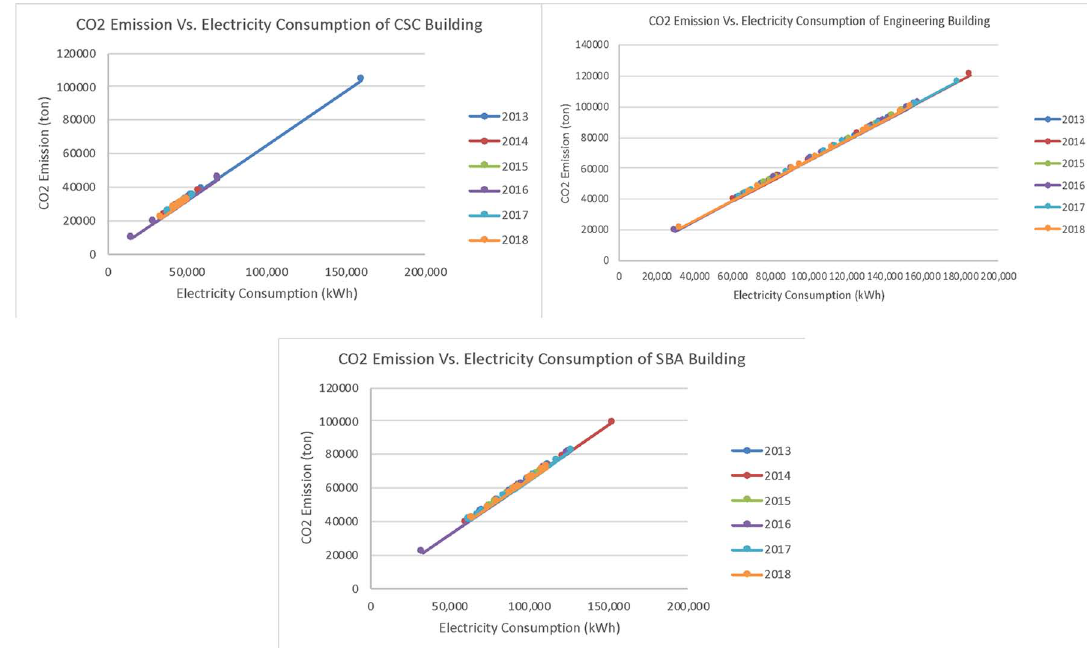
Figure 10. CO2 emission Vs. Electricity Consumption of all the